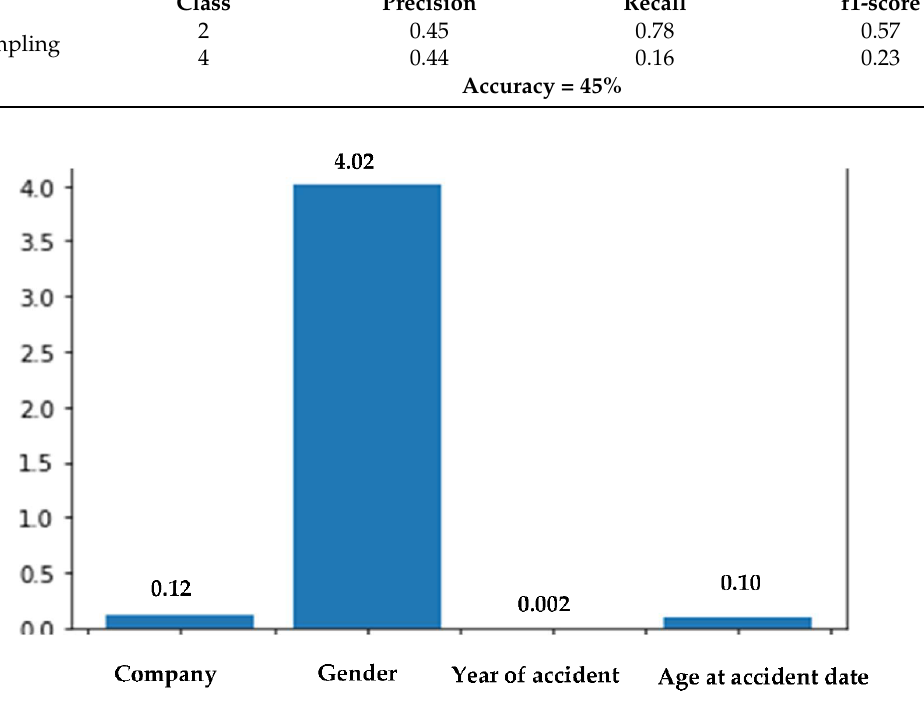
Figure 2. Importance of features in predicting lower extremity injuries and injuries in the Torso and hands region.